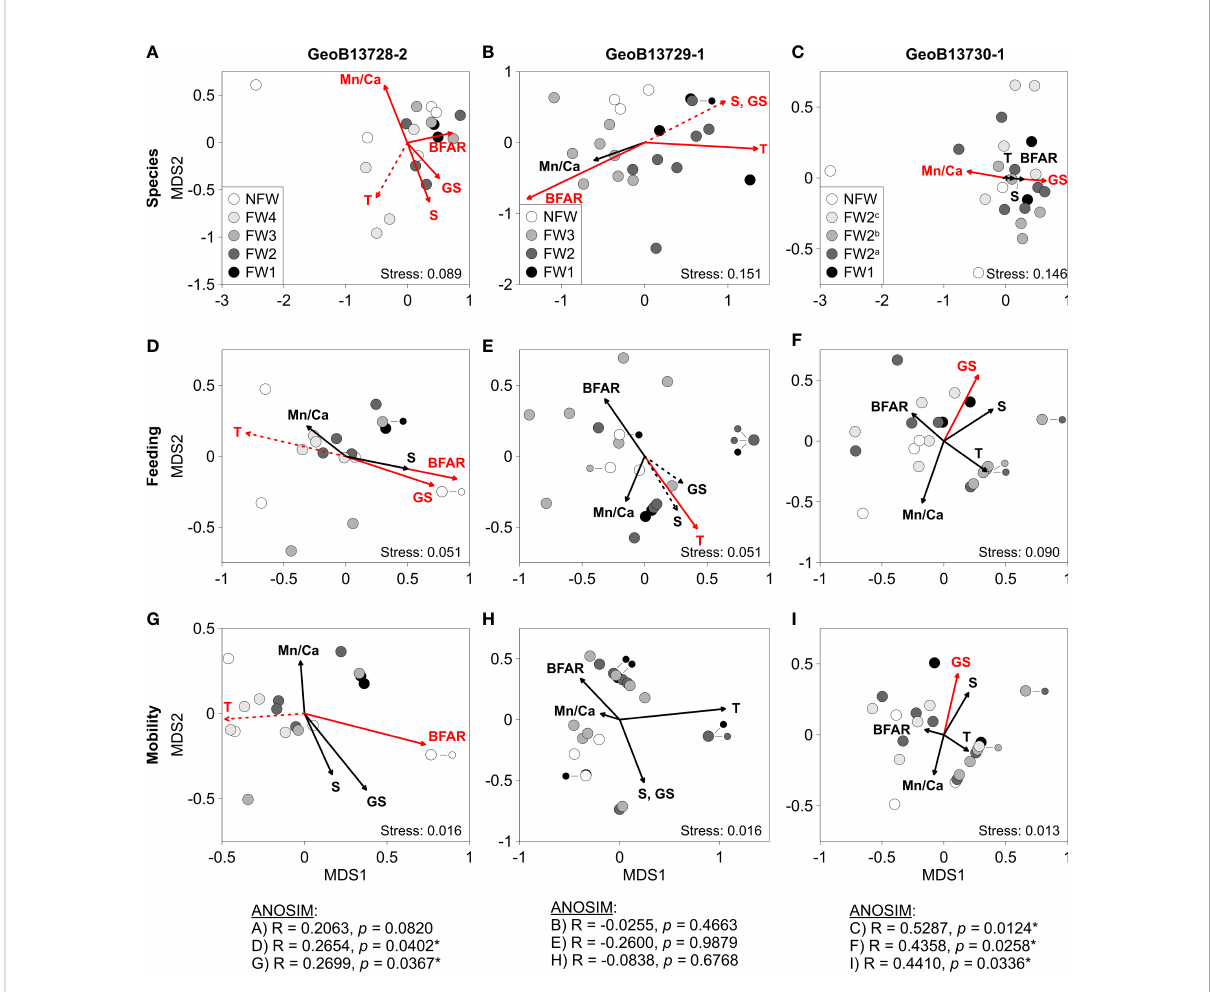
FIGURE 6 Non-parametric multi-dimensional scaling (nMDS) plots of molluscan species (A, D, G) , feeding groups (B, E, H) , and mobility groups (C, F, I) with rotational vector fi tting of palaeoceanographic parameters for cores GeoB13728-2, GeoB13729-1, and GeoB13730-1. Color coding of molluscan assemblages (circles) corresponds with intervals of coral framework (FW) and non-framework (NFW) identi fi ed in Supplementary Figure 1. For core GeoB13730-1, FW2 is subdivided into three (nearly) equal groups due to the large number of assemblages within FW2. Vectors point towards molluscan assemblages with which palaeoceanographic data are correlated. Red vectors indicate signi fi cant correlations between palaeoceanographic data and molluscan data. Vectors with dashed lines indicate results from additional runs of the EnvFit analysis, for which palaeoceanographic parameters in the fi rst runs were excluded due to signi fi cant correlations among parameters. See Tables S6, S7 for parameter correlations and vector p -values, respectively. Palaeoceanographic parameters (measured from the off-mound core GeoB13731-1): BFAR – benthic foraminifera accumulation rate, a proxy for surface ocean productivity and organic matter exported to the sea fl oor (i.e. food availability) (Portilho-Ramos et al., 2022); GS – mean grain size, a proxy for hydrodynamics (current strength) (Fink et al., 2013); Mn/Ca – ratio of Mn/Ca in benthic foraminifera, a proxy for bottom-water oxygenation (Portilho-Ramos et al., 2022); T – Mg/Ca ratio in benthic foraminifera, a proxy for bottom-water temperature (Portilho-Ramos et al., 2022); d 18 O seawater – in benthic foraminifera, a proxy for bottom-water salinity (Portilho-Ramos et al., 2022). ANOSIM R and p -values corresponding with each plot (A-I) and testing for differences between assemblages associated with intervals of coral framework (FW) versus non-framework (NFW) are provided below the plots. * indicates a signi fi cant